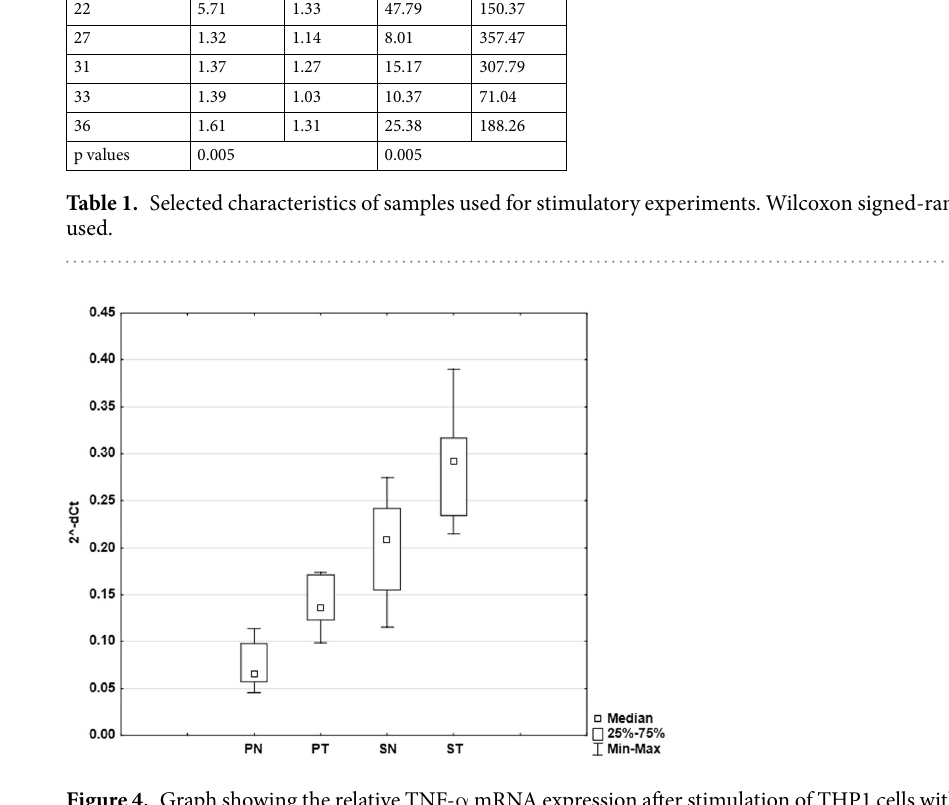
Figure 4. Graph showing the relative TNF- α mRNA expression after stimulation of THP1 cells with different types of sample (PN – non-treated plasma, PT – plasma treated with DNase, SN – non-treated serum, ST – serum treated with DNase). Bars show standard deviations (n = 10). ined by qPCR for single copy gene ( 36B4 ) and they do not revealed any amplification signals. In case of stimulation by DNase treated and non-treated plasma, we found significant difference (p = 0.005) between the levels of TNF- α mRNA expression. DNase treatment of plasma samples led to statistically signif- icant enhancement of their stimulatory activity in the term of increase of relative TNF- α mRNA expression (0.14 ± 0.02 vs. 0.07 ± 0.02, respectively) (Fig. 4). The same trend was observed between treated and non-treated serum samples (0.29 ± 0.05 vs. 0.21 ± 0.05 respectively, p = 0.013). Statistically significant (p = 0.005, Wilcoxon test) differences were observed in stimulation activity between non-treated plasma and serum samples. DNase non-treated serum samples stimulated the relative TNF- α mRNA expression in higher extent than non-treated plasma samples (0.21 ± 0.05 vs. 0.07 ± 0.02, respectively). DNase treated serum samples had also higher stimu- latory effect than treated plasma samples T (0.29 ± 0.050 vs.14 ± 0.02, respectively). The results of stimulatory experiments are summarized in Fig. 4. When we compared the performance of all ten quartets of samples in stimulatory experiments we observed again nearly the identical scenario in all examined individuals: The lowest values of relative TNF- α mRNA expression were found when the cells were stimulated using DNase non-treated plasma samples. After DNase treatment, the plasma samples enhanced their stimulatory capacity (fold change difference 1.86) which was still lower or almost identical as stimulatory capacity of DNase non-treated serum samples. DNase treatment of serum samples in most cases enhanced their stimulatory capacity (fold change difference 1.4) above the capacity of non-treated serum. To estimate the content of telomeric sequences in each sample used for stimulatory experiment, we calculated ETAT values as described in Methods. We found significant differences (p = 0.005, Wilcoxon test) between ETAT values of plasma and serum samples (Table 1).